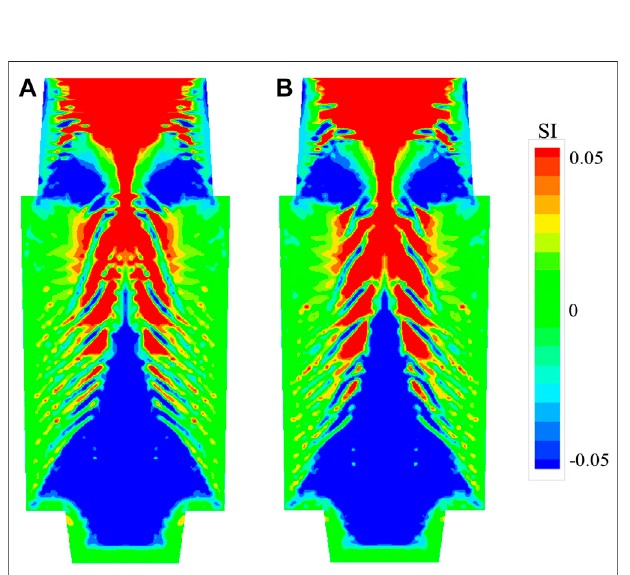
FIGURE 6 | Segregation index (SI) in the longitudinal section of ingot: 1) simulation result of the three-phase model, 2) simulation result of the four- phase inclusion model.